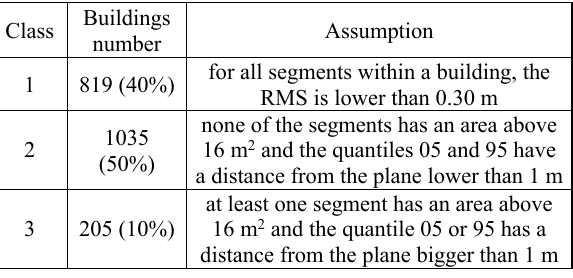
Figure 4. The presentation of the qualitative assessment results of LOD2 models for individual buildings in the Warsaw test area: Class 1 - blue, Class 2 - green, Class 3 - red (see Table 3).